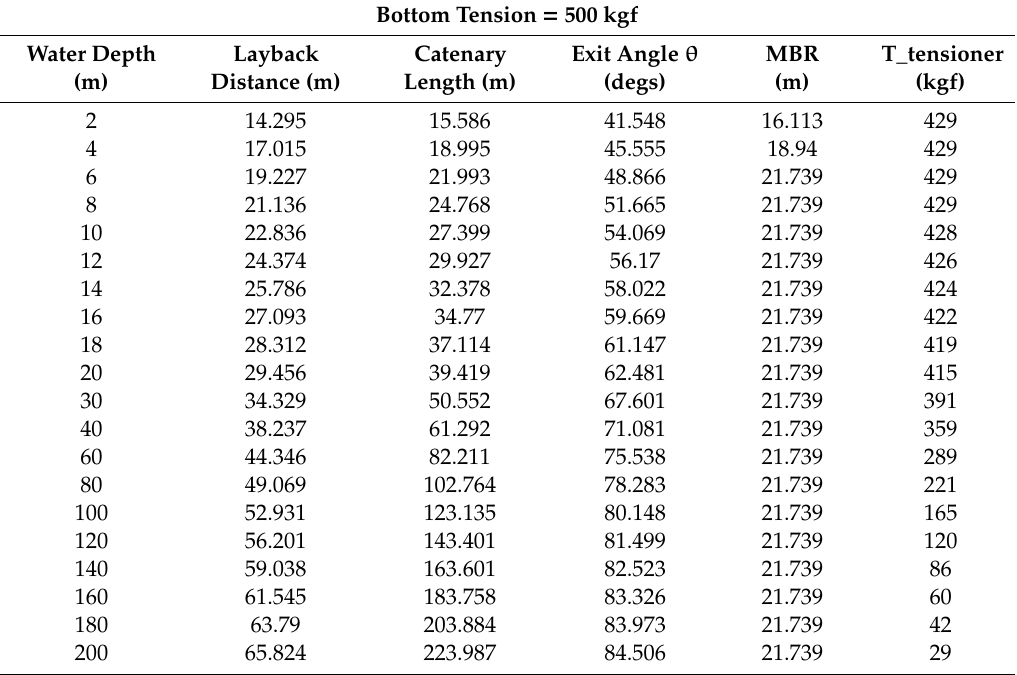
Table 2. Water depth and bottom tension combined e ff ects—Constant bottom tension at 500 kgf VS Di ff erent water depth values.